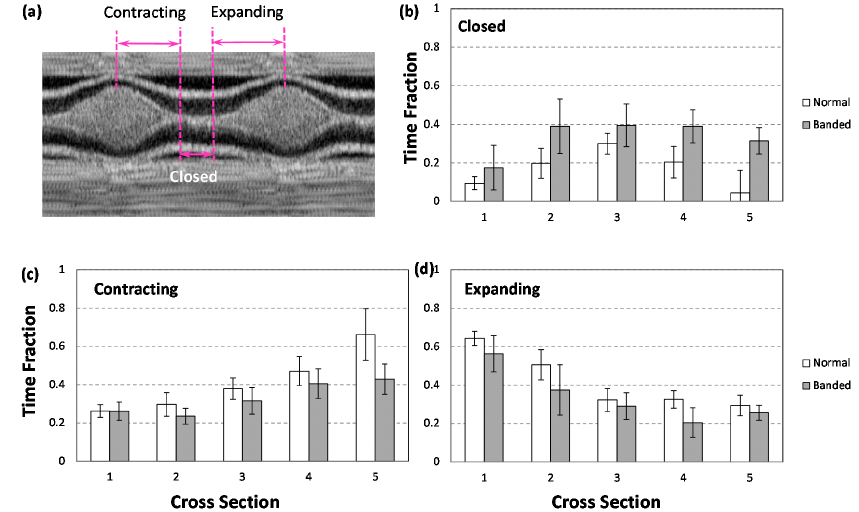
Figure 3. OFT wall dynamics under control and banded conditions. Analysis was done based on 4D OCT images (control n = 7; banded n = 6), with cross-sectional locations indicated in Figure 1. ( a ) shows an M-mode OCT image to illustrate the criteria employed to describe the wall motion. The data shows comparisons of the fraction of the cardiac cycle over which ( b ) the lumen was closed and OFT walls were ( c ) contracting and ( d ) expanding. Data displays average ˘